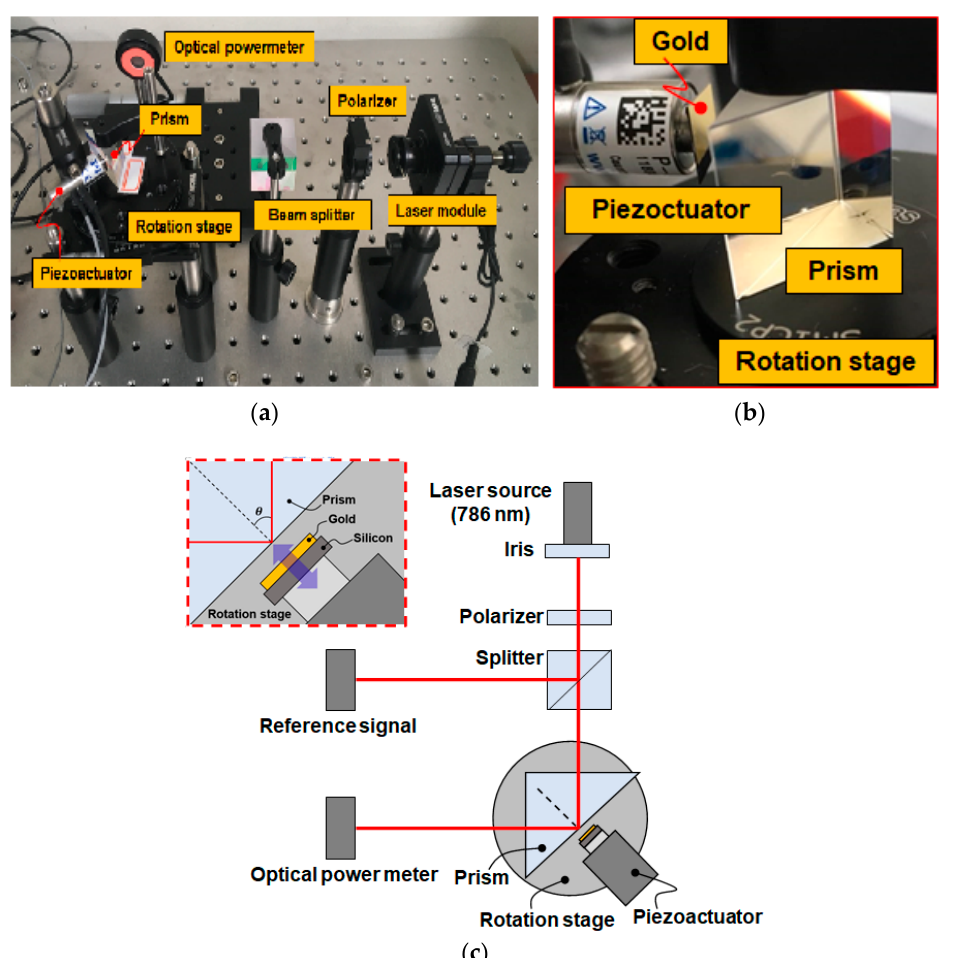
Figure 10. Reconfigurable Otto SPR system using a piezoactuator. ( a ) reconfigurable Otto SPR system experimental setup; ( b ) piezoactuator experimental setup; ( c ) schematic view.